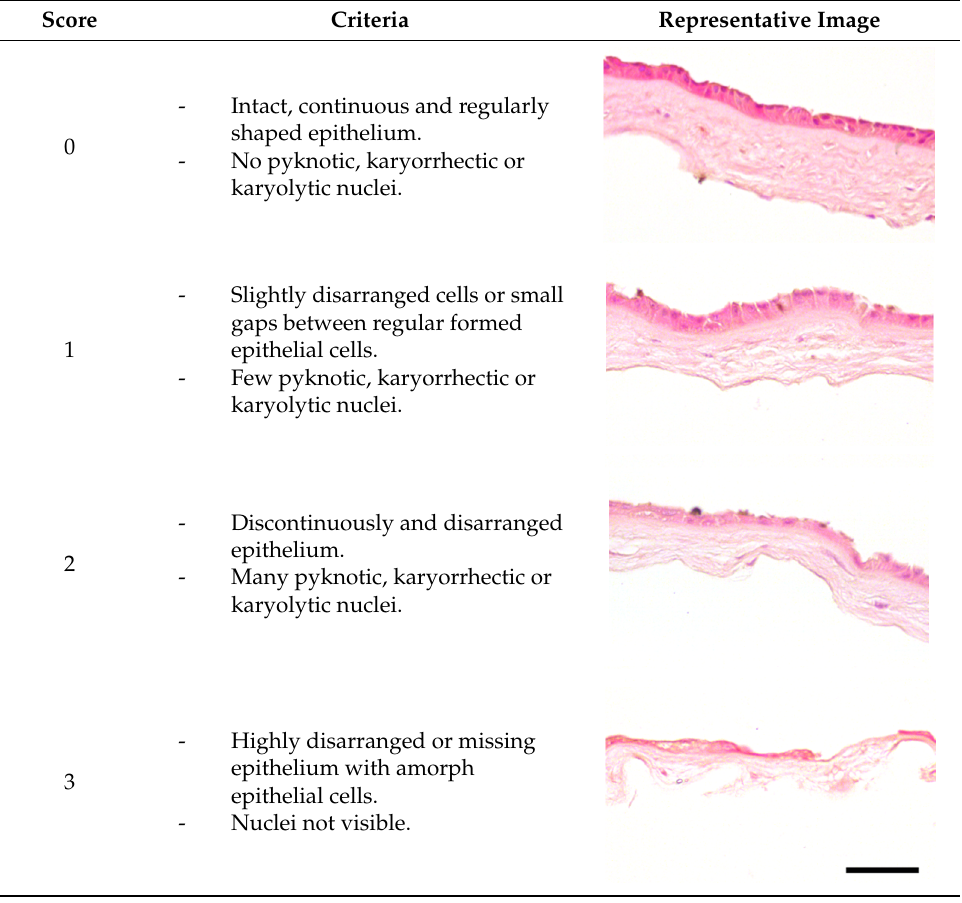
Table 2. Scoring and exemplary HE-stained histological images of hAM epithelium. Scale bar 50 µm.